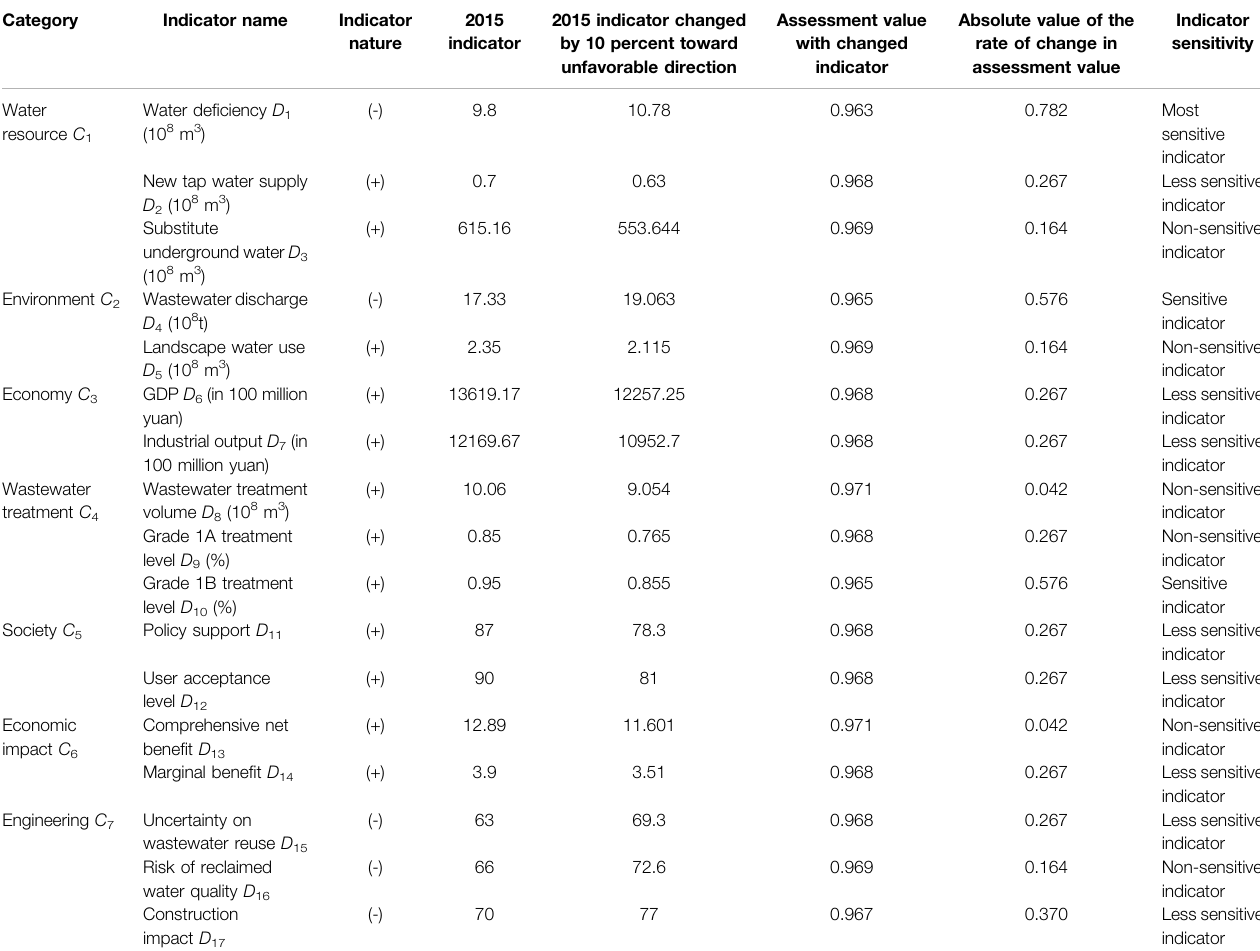
TABLE 9 | Indicator sensitivity analysis